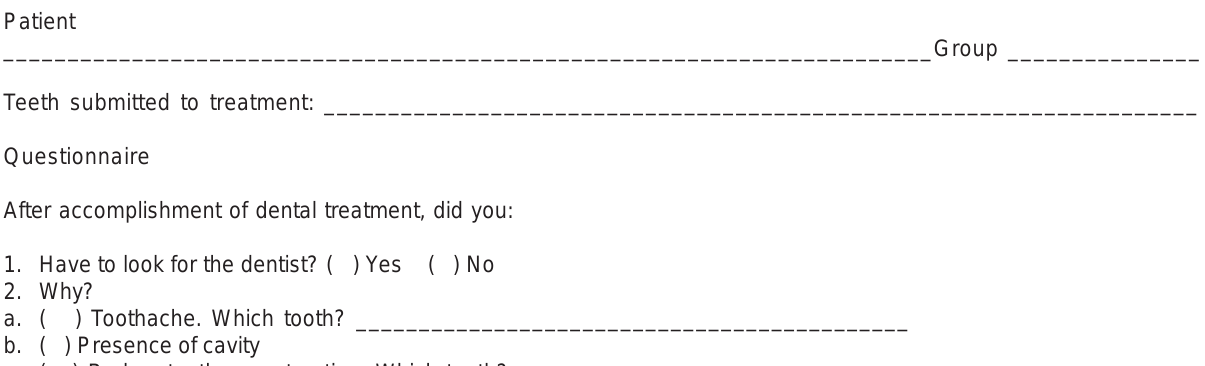
FIGURE 2- Questionnaire regarding the dental treatment